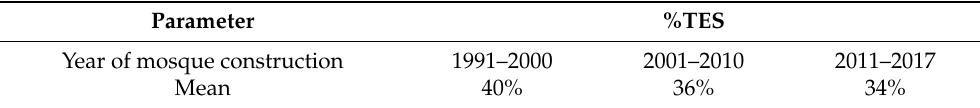
Table 4. Comparison of different categories of mosques based on year built, showing the mean and median values of total percentage of energy